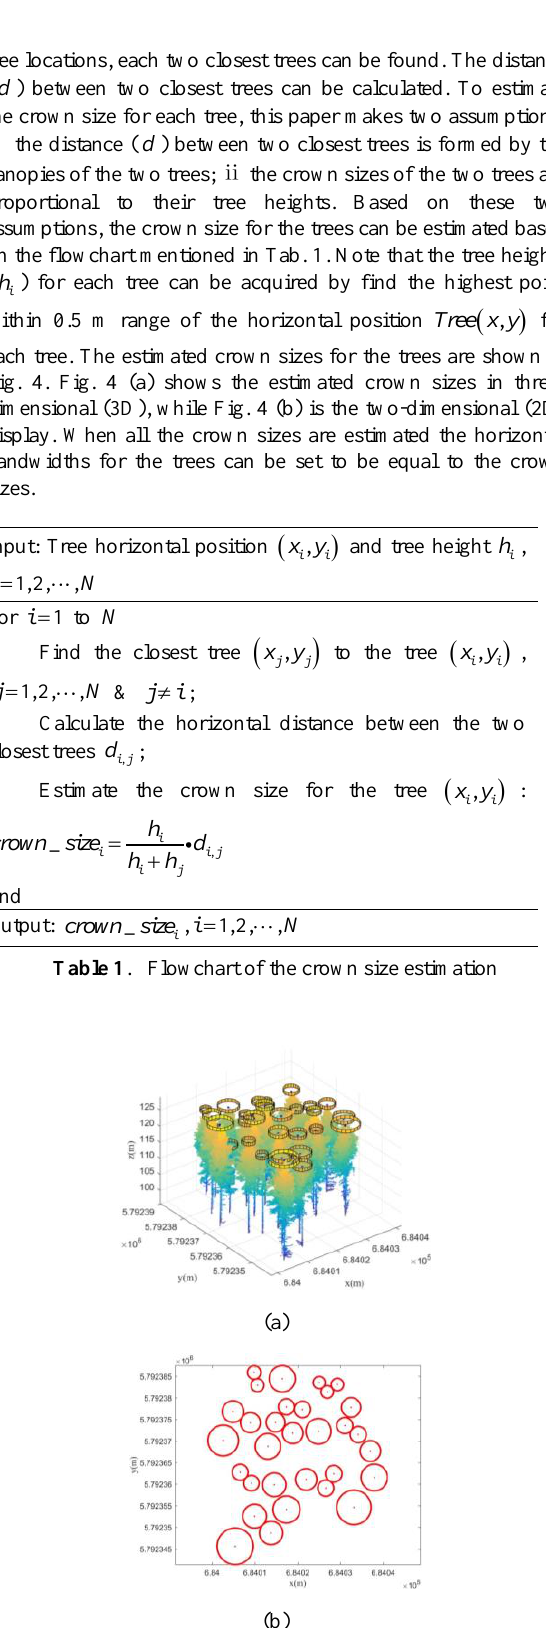
Figure 2 . UAV LiDAR point clouds and the extracted trunk points. (a) UAV LiDAR point clouds for the trees; (b) the extracted trunk points.